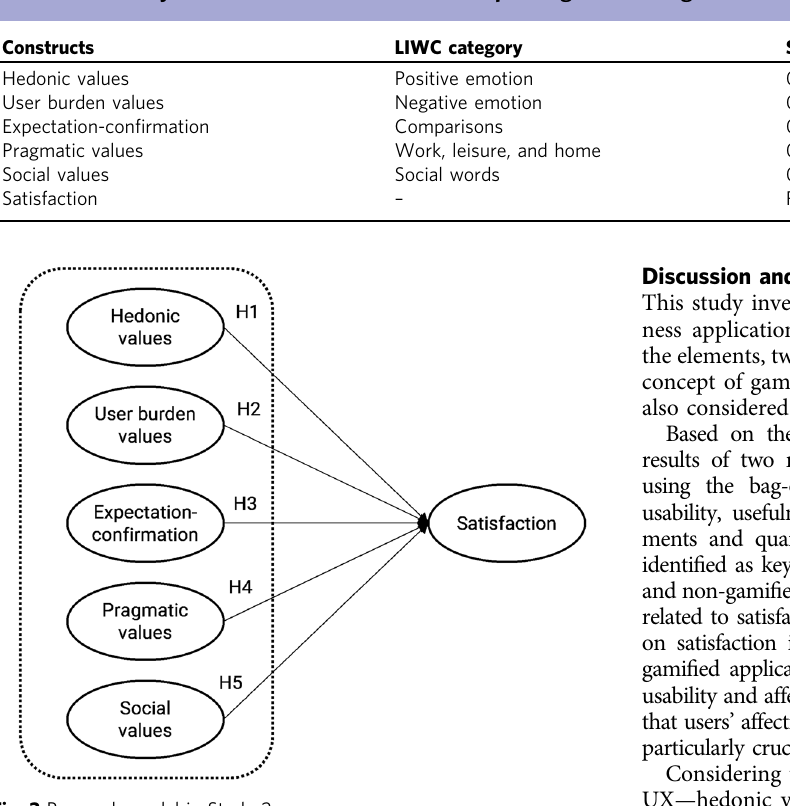
Table 1 Summary of the measurements and corresponding LIWC categories.